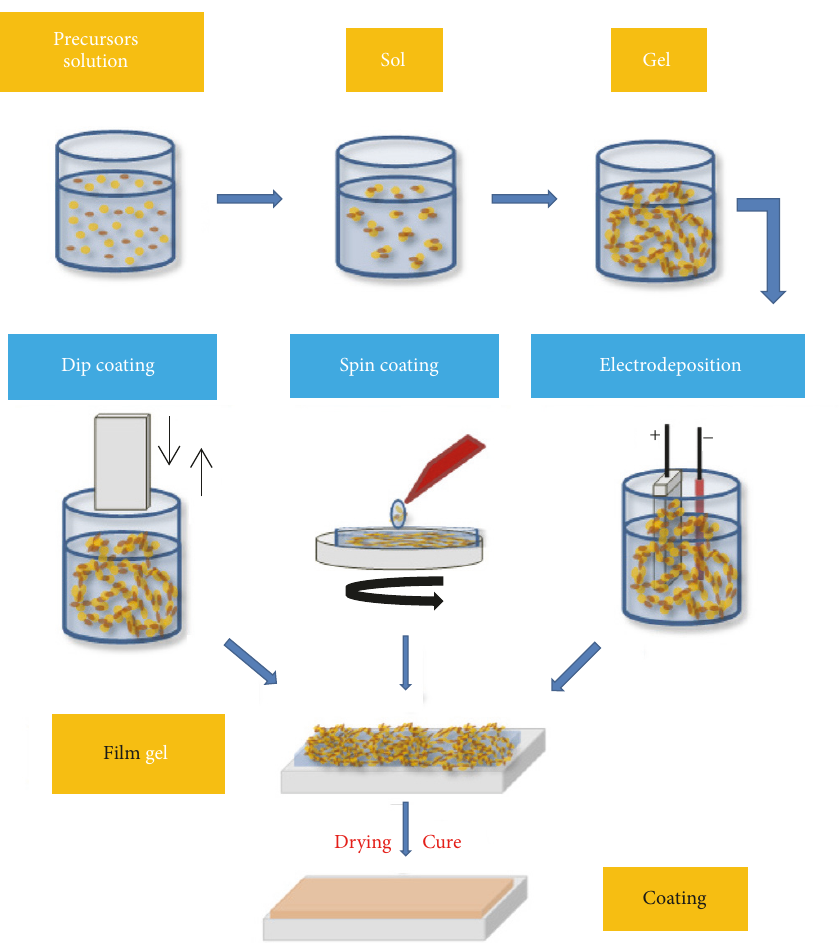
Figure 1: Preparation of coatings by sol-gel method